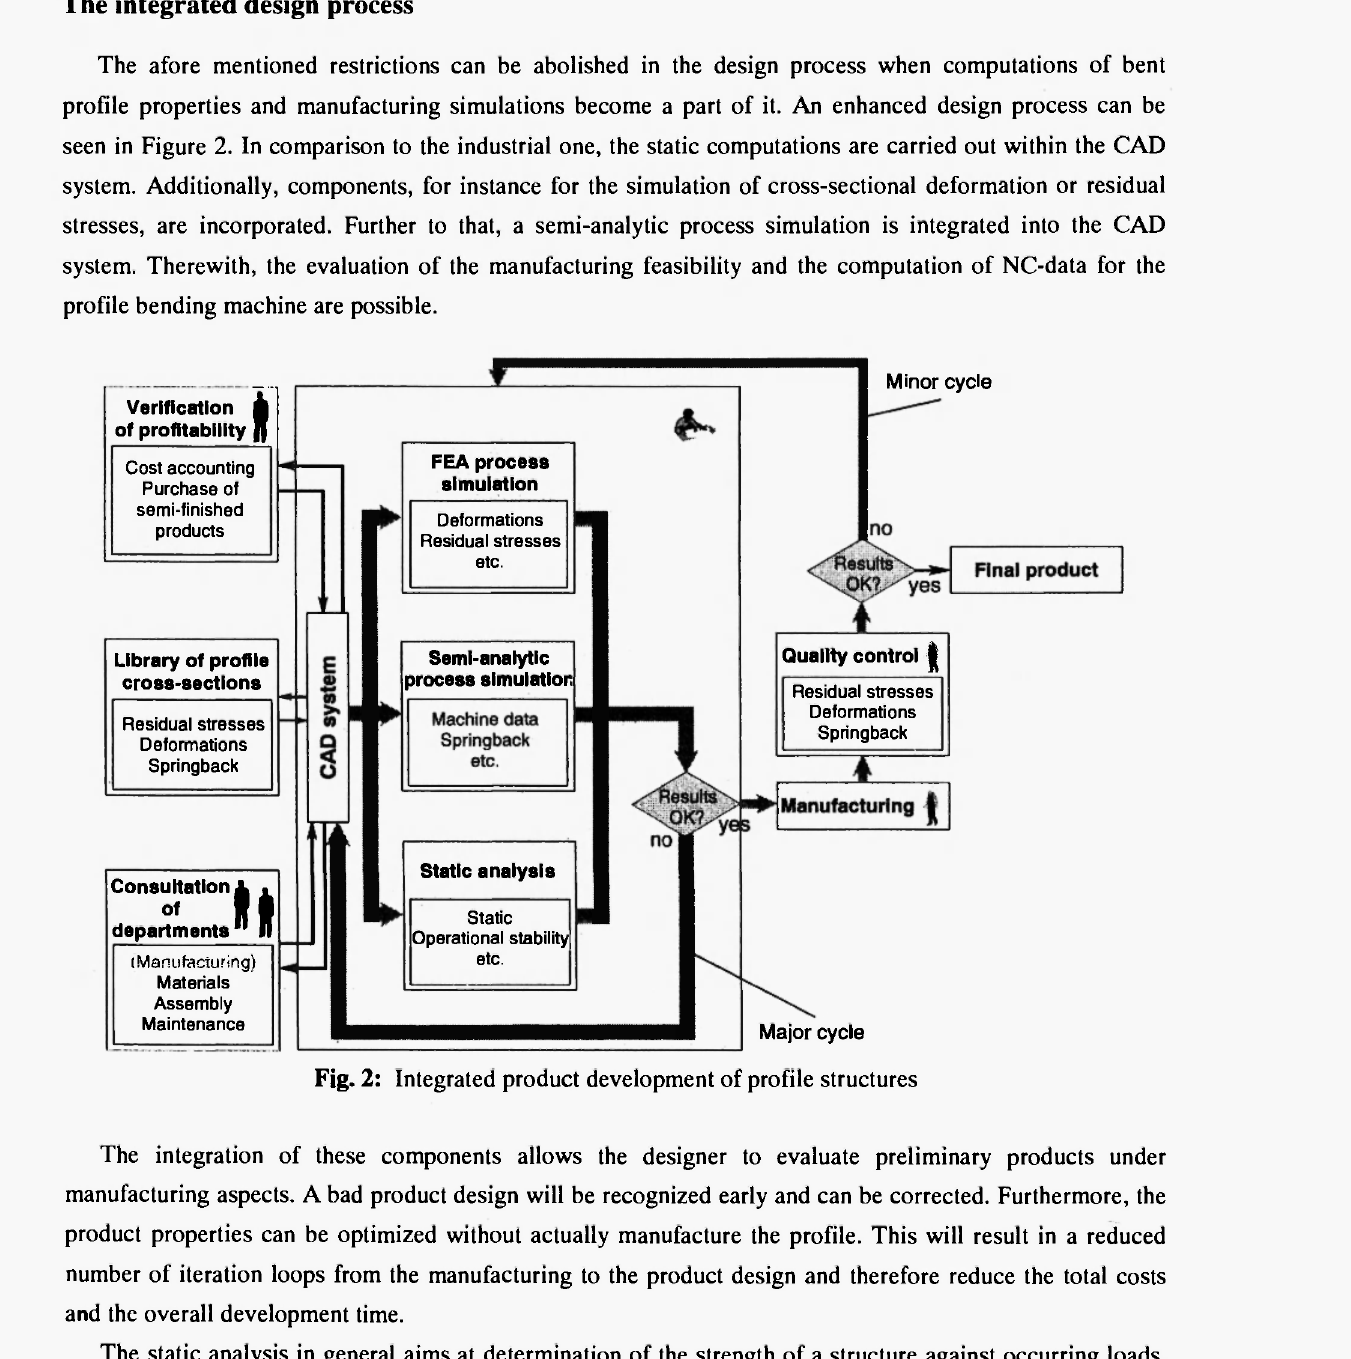
Fig. 2: Integrated product development of profile